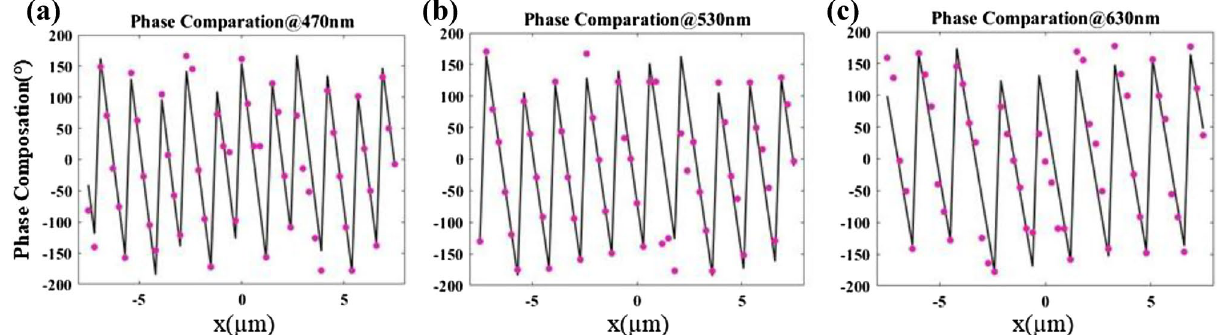
Figure 5. ( a – c ) Comparisons of the target phase profiles (solid lines) and actual phase profiles (dot lines) of the deflecting layer at the wavelengths of 470 nm, 530 nm and 630 nm, respectively.